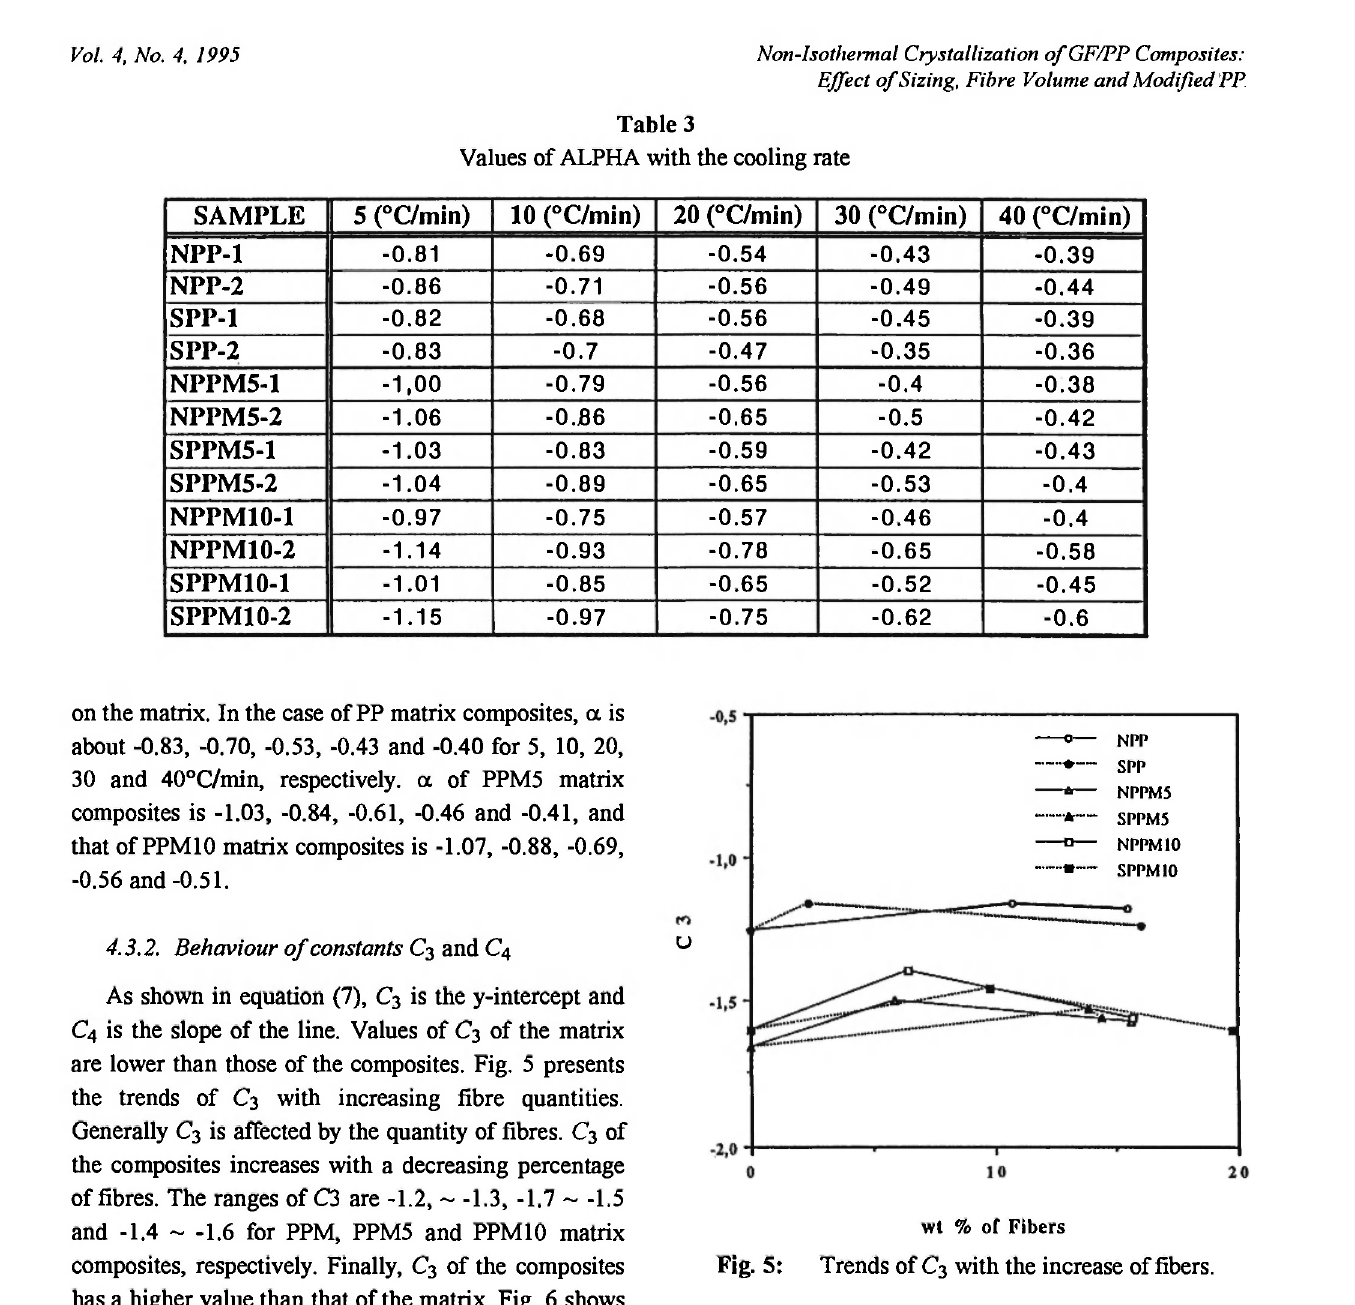
Trends of C3 with the increase of